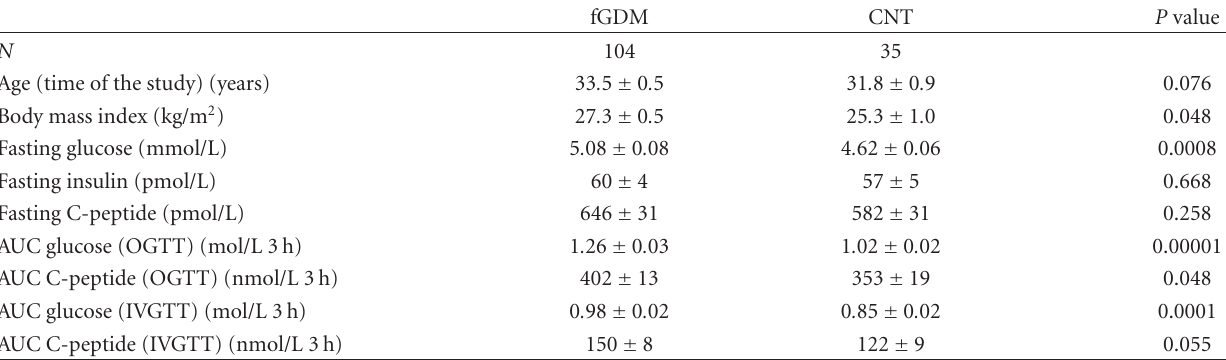
Table 1: Main characteristics and area under the concentration curve (AUC) of glucose and C-peptide, in the two tests, for women with former gestational diabetes (fGDM) and women who had normal pregnancy (CNT). fGDM CNT N 104 Age (time of the study) (years)